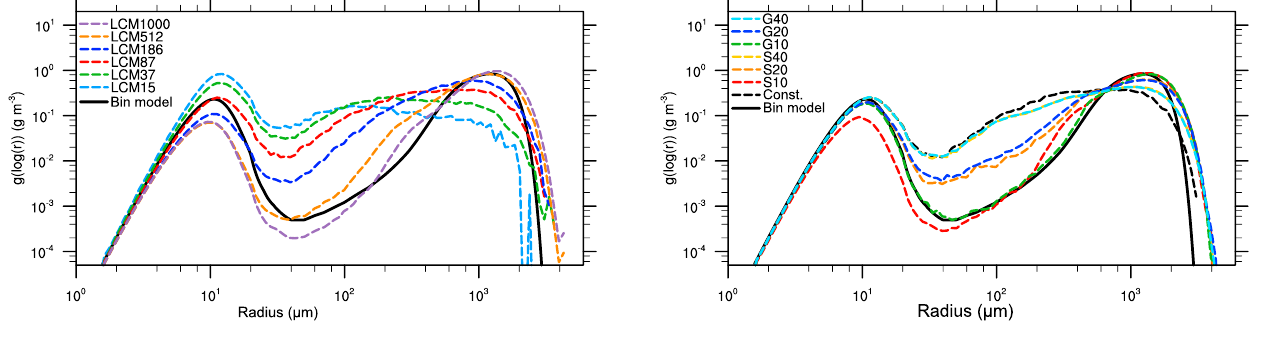
Figure 9. Same as Fig. 5 but for the multi-box approach, i.e., inter- actions between the grid boxes are